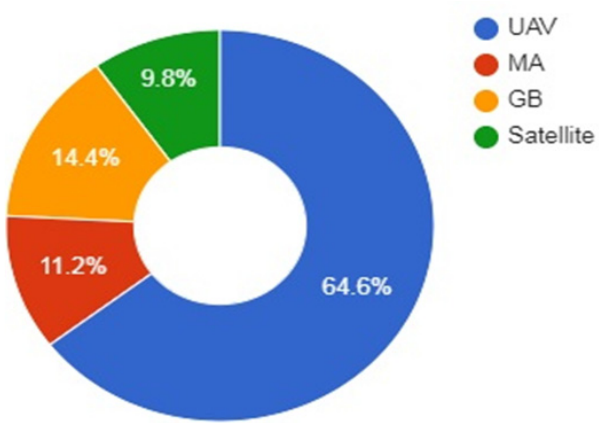
Figure 10. Average usage of RS platforms.